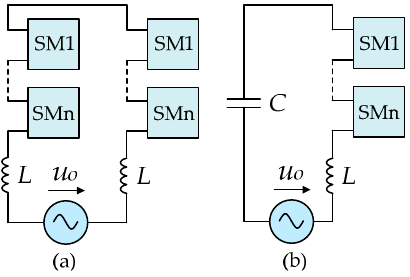
Figure 15. Simplified RPC based on a half bridge indirect modular multilevel converter (HB-MMC2 RPC) (based on [31,58]).